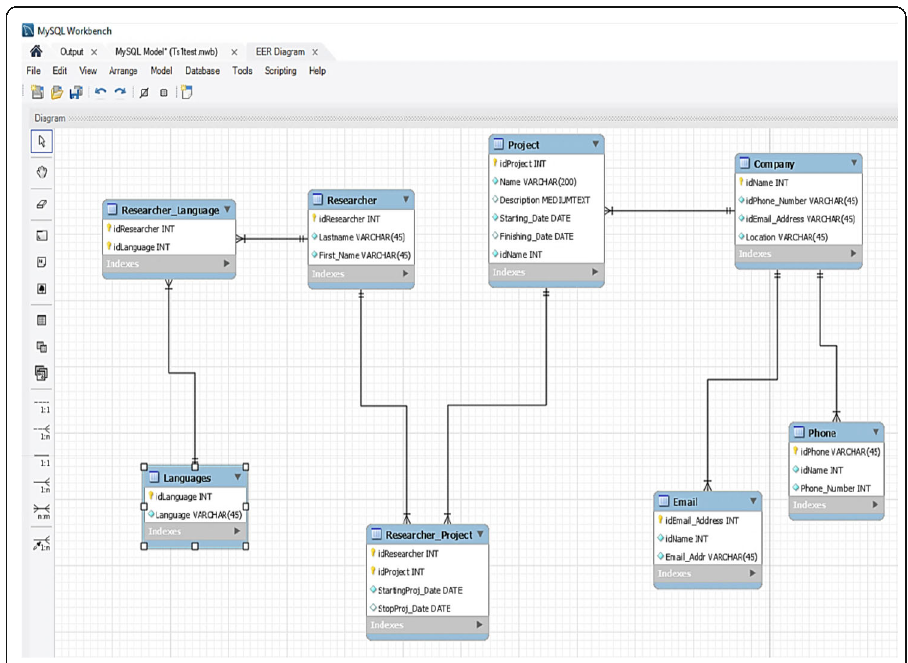
Fig. 6 The physical part of the database using MySql Workbench